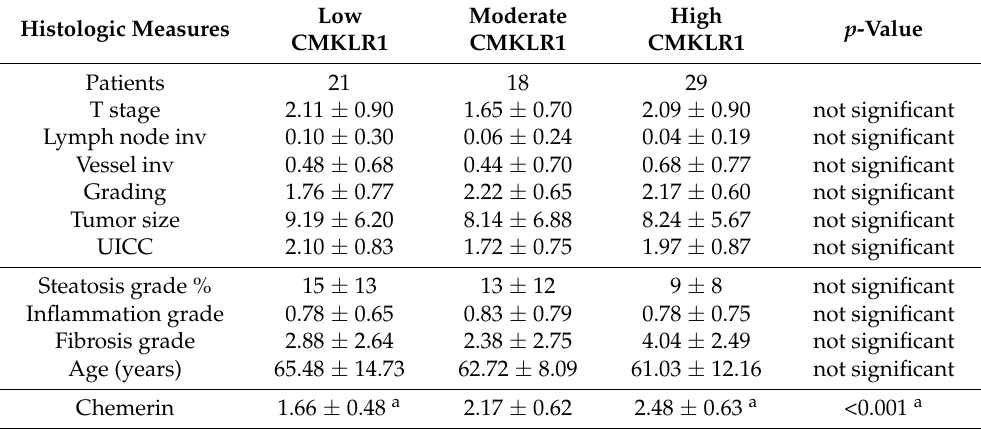
Table 5. T stage, lymph node invasion, vessel invasion, grading, tumor size, UICC stage, steatosis, inflammation, fibrosis stages, age, and chemerin scores of female patients stratified with low, moder- ate, and high CMKLR1 protein in the tumors. a: comparison of tumors with low and high chemerin (inv,